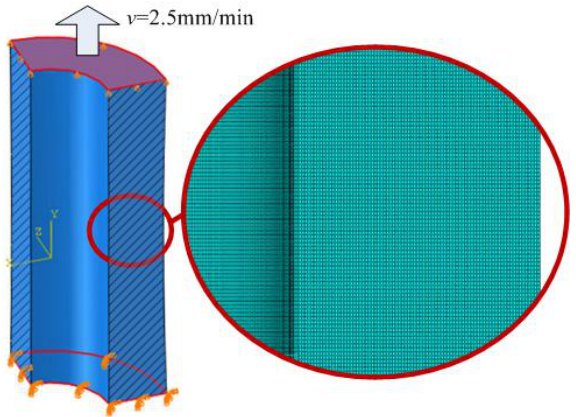
Figure 4. Finite element model of tube tension.